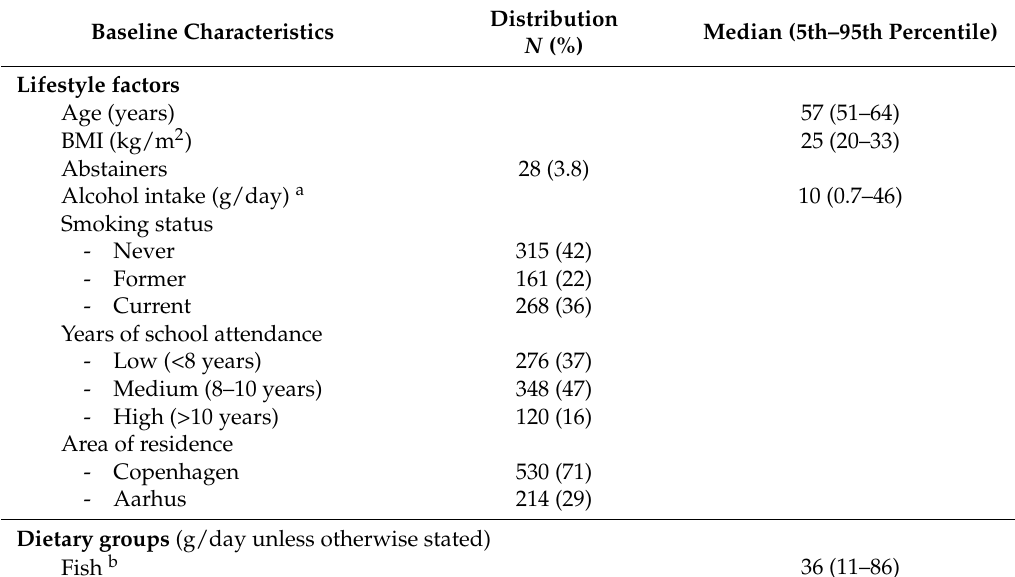
Table 1. Baseline characteristics of the study population ( N =